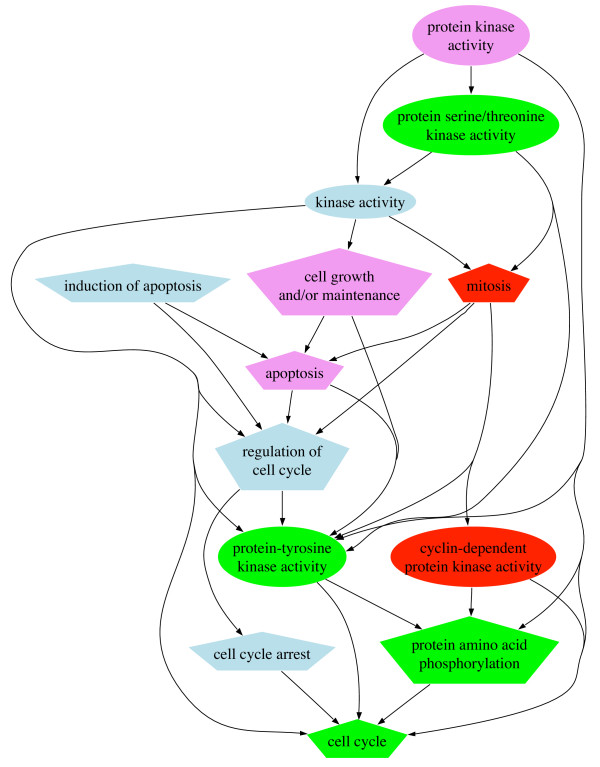
A selective part of the network of inter-dependent terms for cdc2. Shape: ellipse = Function, polygon = Process. Annotations: GOA (Evidence), PUB (Literature) and DEP (Associative relations). Color: Venn categories, red = GOA+PUB+DEP, green = GOA+DEP, lightblue = PUB+DEP, violet = DEP. Arrows indicate the way the dependence was found in our associative database.